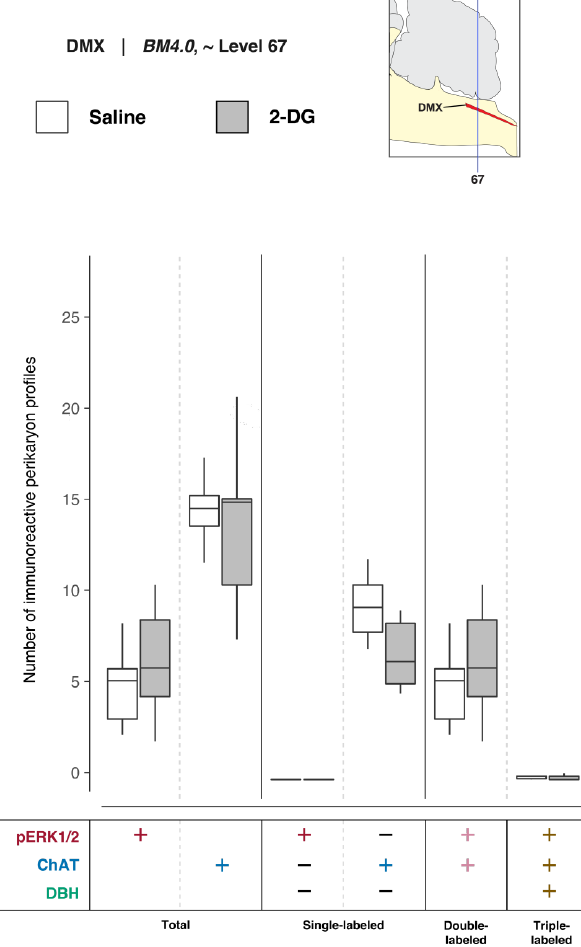
Figure 7. 2-DG administration, at a group level, is not associated with an alteration of activation patterns in the dorsal motor nucleus of vagus nerve (>1840) (DMX) perikaryon profiles registered to BM4.0 atlas level 67. Abercrombie-corrected [106] perikaryon profile counts from both saline- and 2-DG-treated subjects are represented as box plots displaying the total numbers of phospho-ERK1/2- or ChAT- or DBH-immunoreactive profiles, or only the single-, double-, and triple-labeled profiles, from tissue sections identified to be in register with BM4.0 atlas level 67 (map, upper right ). Differences in the numbers of perikaryon profile were not significant; see Tables S3 and S4 for a statistical summary. In the absence of significant changes in the number of DMX perikaryon profiles, the relative percentages of Abercrombie-corrected single-, double-, and triple-labeled profiles were calculated for saline and 2-DG groups and visualized as pie charts in Figure S3. The majority of the pERK1/2 + perikaryon profiles in the DMX at level 67 were identified to be ChAT + but negative for DBH in both saline- (97.7%) and 2-DG-treated (97.8%) rats (Figure S3, pERK1/2 + row, pERK1/2 + and ChAT + ; magenta-colored fraction). Interestingly, for the